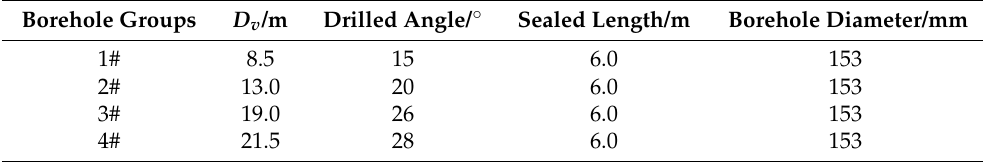
Figure 8. The enlarged scope of A–A’ test drilling area in Figure 7. Table 2. Drilling parameters of test boreholes.